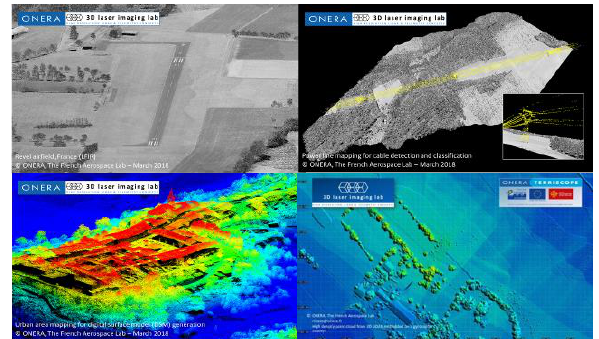
Figure 12. Point clouds measured with the VUX-SYS-LR on gyrocopter: Revel Airfield, France (top left), powerline mapping (top right), urban area mapping (bottom left), and point cloud density in false colours (bottom